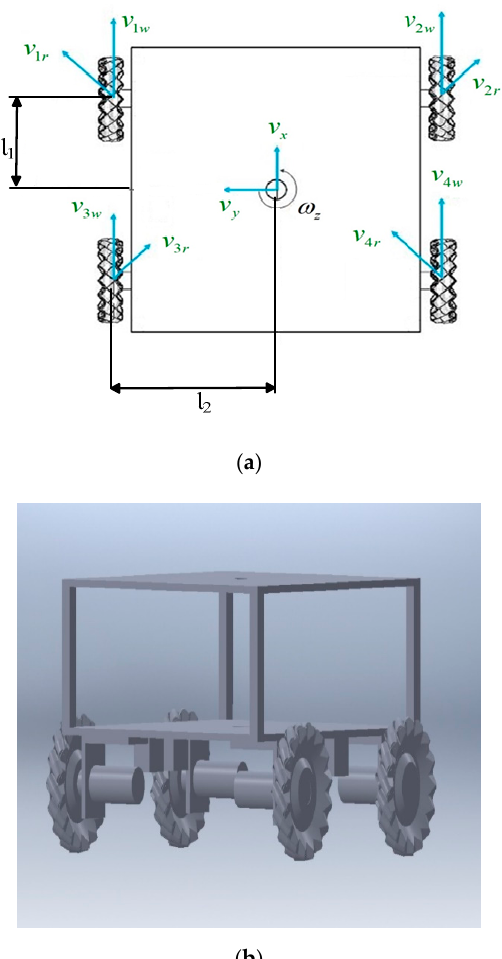
Figure 2. Structure of the omni-Mecanum-wheeled autonomous vehicle ( a ) bottom view ( b ) front view.